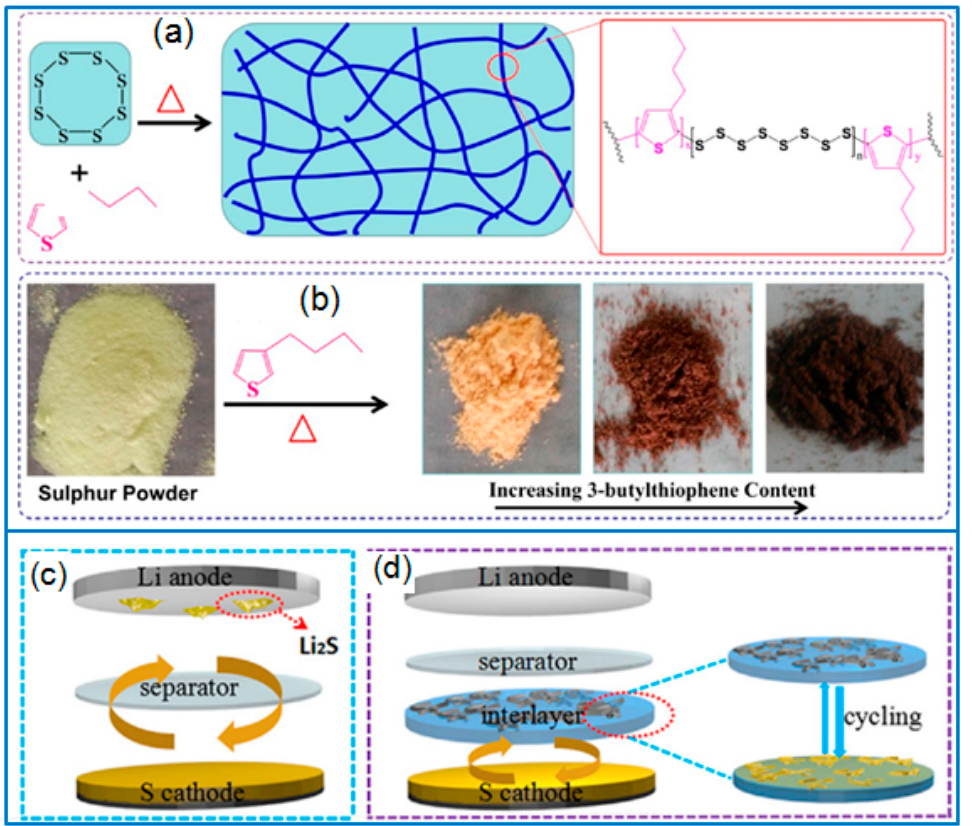
Figure 8. ( a ) The synthesis of S3BT and ( b ) the color change of different samples [100]; The configuration of Li-S cell with ( c ) normal separator and ( d ) the PEDOT:PSS-CNT interlayer [102].